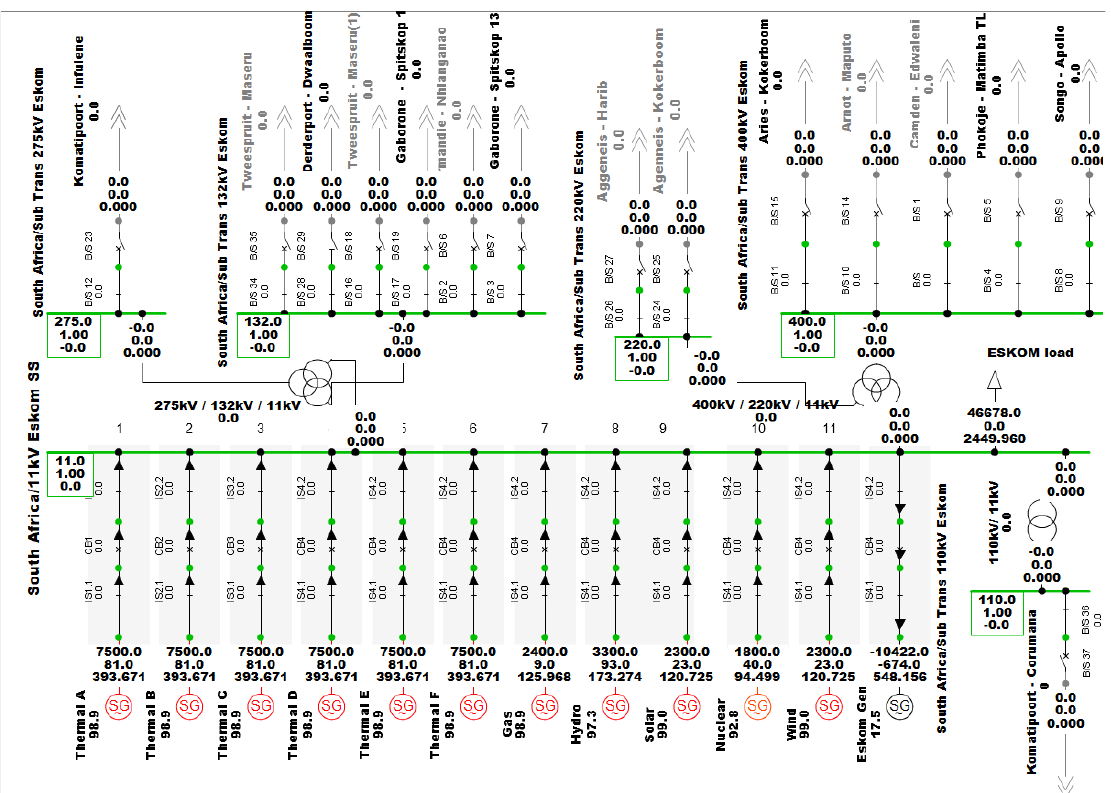
Figure 6. Lesotho network model.